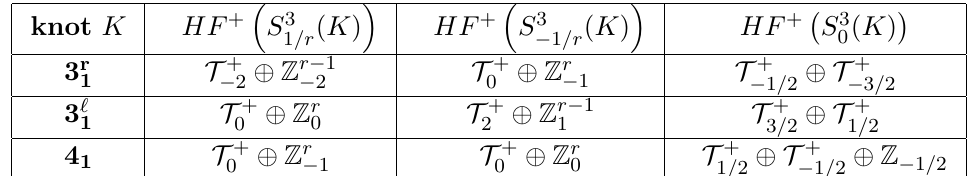
Table 3 . Heegaard Floer homology for 1 =r -surgeries and 0-surgeries behaves \discontinuously" as 1 =r ! 0, i.e. HF +